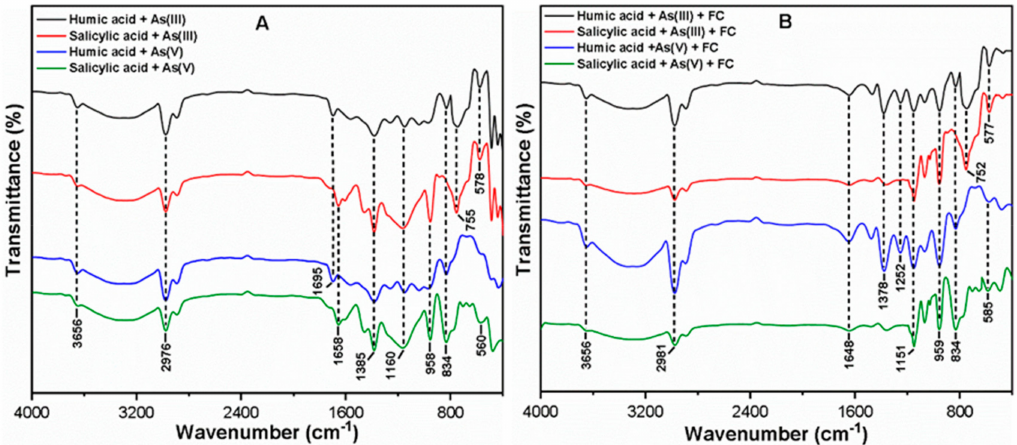
Figure 6. Fourier transform infrared (FT-IR) spectra of ( A ) As(III, V) species after interaction with organic ligands and ( B ) FC composite flocs after the C / F / S